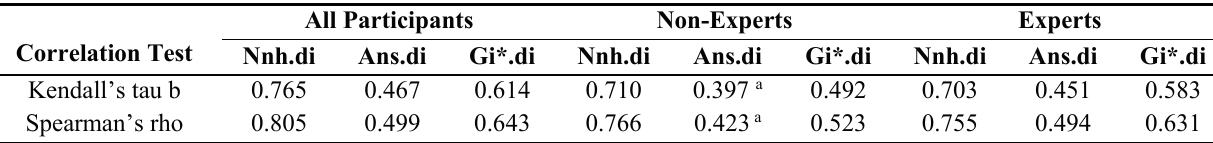
Table 4. Correlation between perceived similarity and local divergence indices. a Correlation is significant at the 0.05 level (2-tailed). All other correlations are significant at the 0.01 level